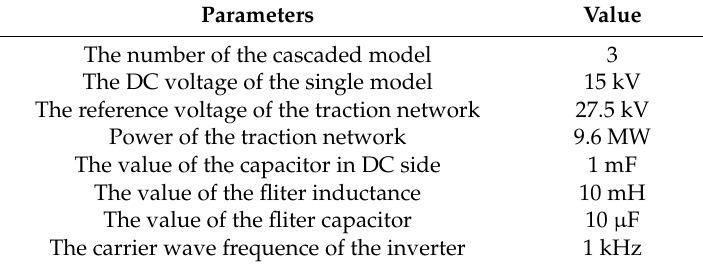
Table 5. The parameters of the three-model cascaded converter simulation.